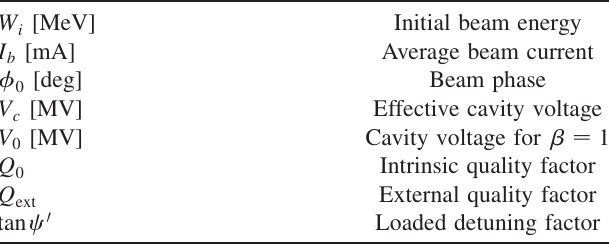
TABLE II. List of simulation input